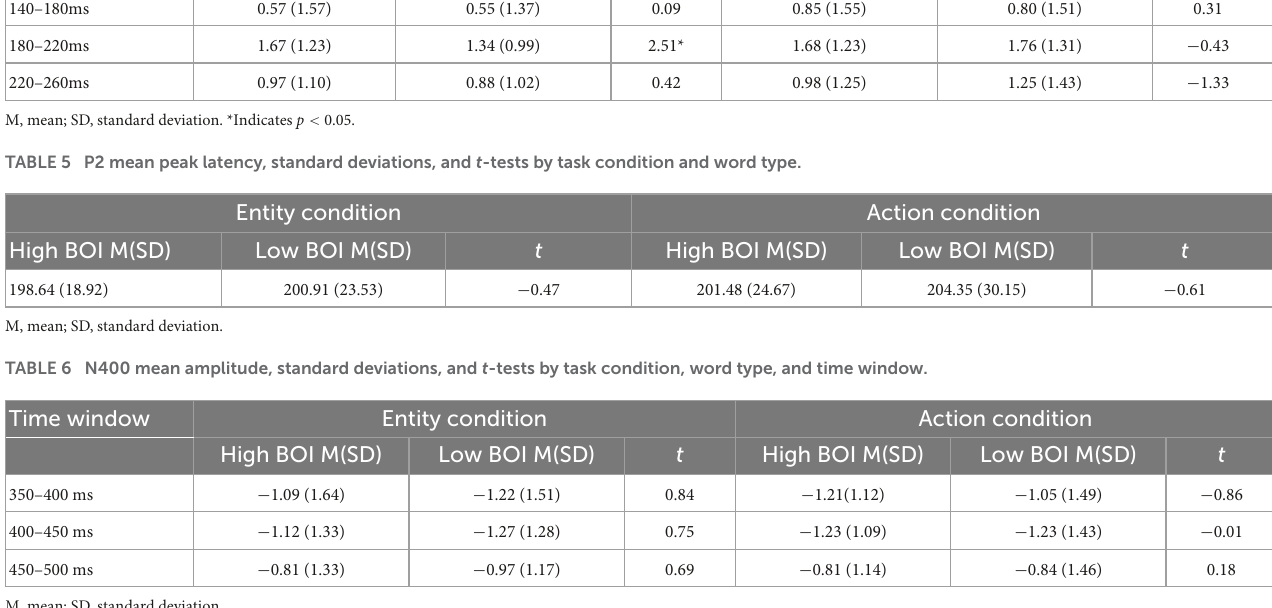
TABLE 7 N400 mean peak latency, standard deviations, and t -tests by task condition and word type. Entity condition Action condition High BOI M(SD)